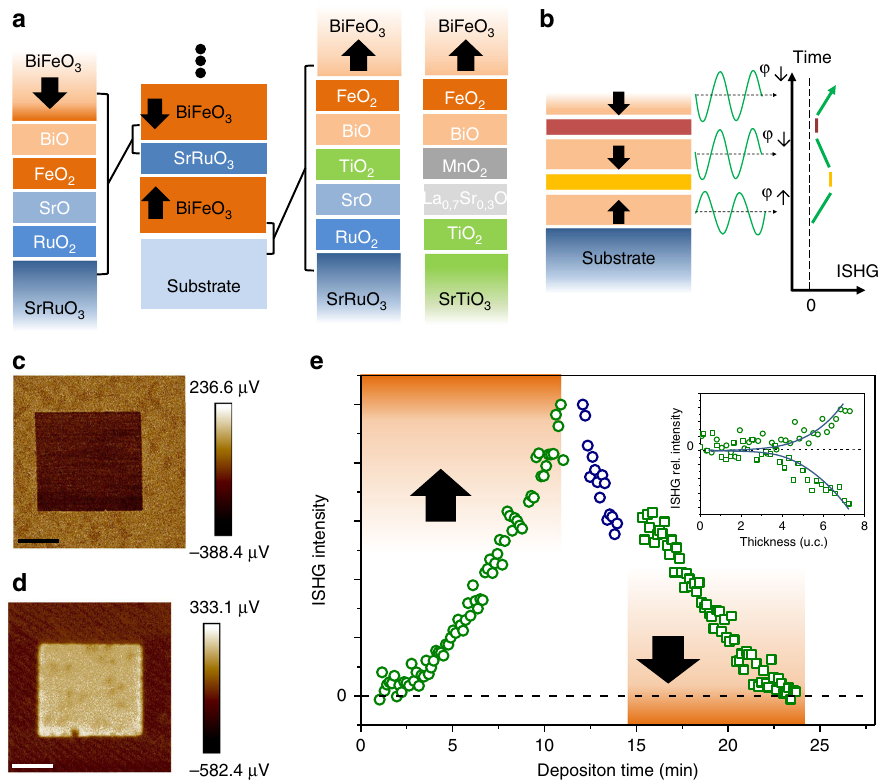
Fig. 4 Engineering ferroelectric multilayers with user-de fi ned up/down polarization sequence II. a A-site growth and upwards polarization of BiFeO 3 (BFO) is achieved by insertion of a TiO 2 monolayer between SrRuO 3 (SRO) and BFO or by substituting SRO by MnO 2 -terminated La 0.7 Sr 0.3 MnO 3 . B-site growth and downwards polarization of BFO is achieved by SrO self-termination of the SRO. b Sketch of multilayer with varying direction of polarization in different layers. The second harmonic generation contributions from these layers may interfere constructively or destructively depending on the respective in situ second harmonic generation (ISHG) phase ( φ ↓ or φ ↑ with φ ↓ – φ ↑ = 180°). c Piezoresponse force microscopy (PFM) scan con fi rming the up-orientation and reversibility of polarization for an A-site-grown BFO fi lm of 20 unit cells. d PFM scan con fi rming the down-orientation and reversibility of polarization for a B-site-grown BFO fi lm of 20 unit cells. In c , d , the scale bar corresponds to 1 µ m. e ISHG from a sequence of oppositely polarized ferroelectric BFO layers (open green circles: up polarization, open green squares: down polarization). The opposite orientation manifests as destructive interference of the ISHG contributions from the two layers. The inset emphasizes the identical critical thickness for the emergence of the polarization in both BFO layers (lines are guides to the eye). Further deposition of down-polarized BFO results in a recovery of the ISHG signal as shown and discussed in Supplementary Fig.